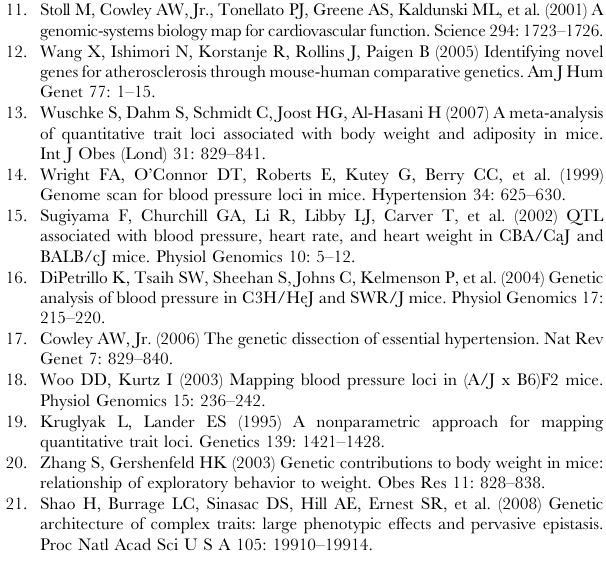
Table S10 Enrichment Analysis for causal genes in trans8_- eQTL signature.